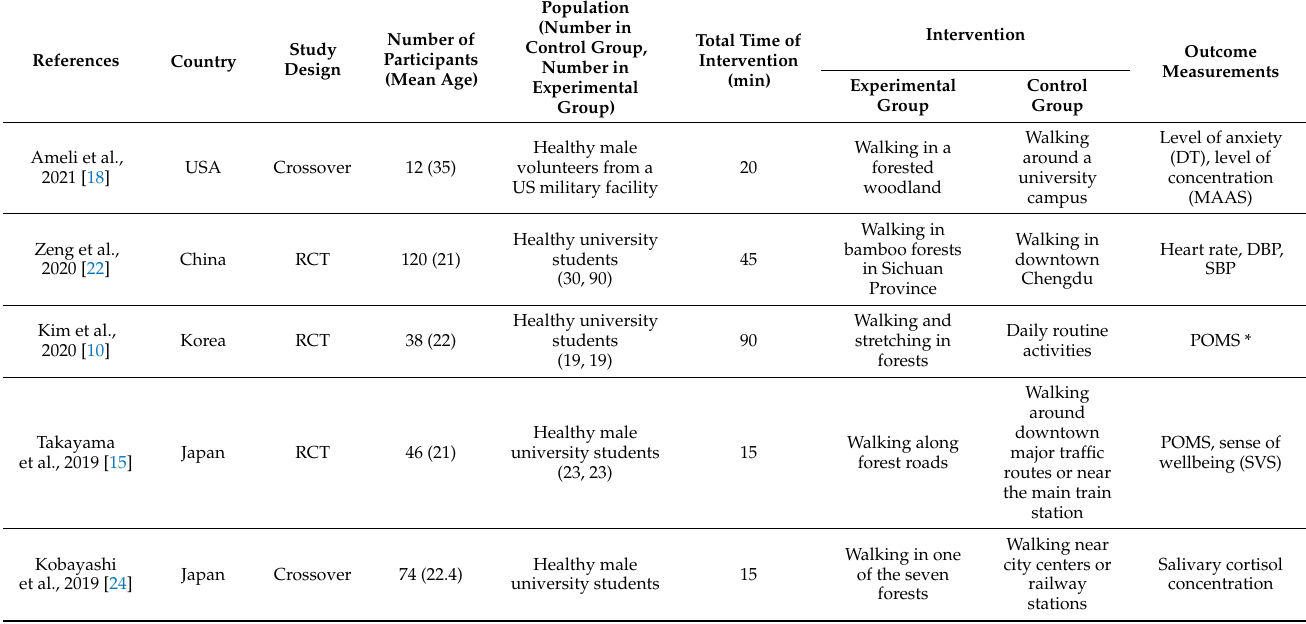
Table 1. Characteristics of the included studies on the psychological and physiological effects of forest